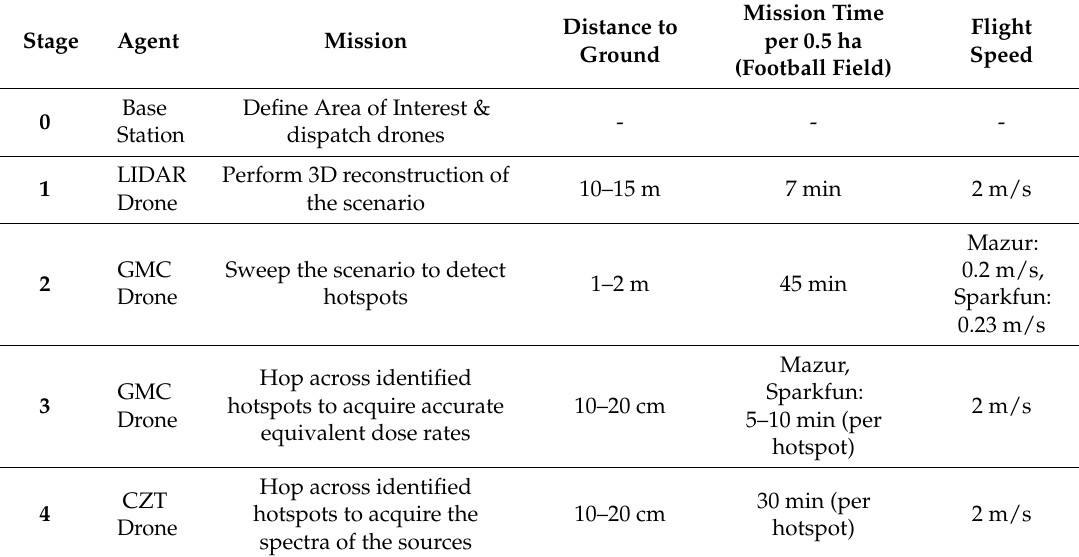
Table 8. Mission summary and physical parameters for each agent present in each Stage of the proposed flight strategy.